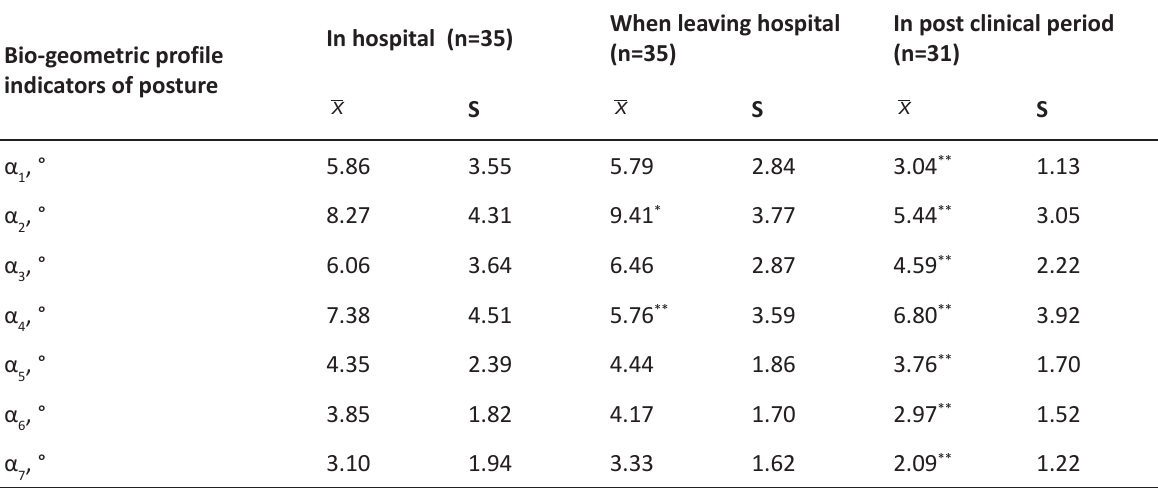
Table 2. Mean statistic indicators of bio-geometric profile of children with functionally one ventricular in sagittal plane at different stages of the research